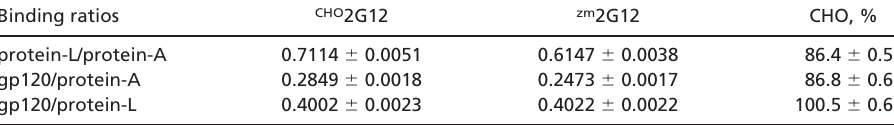
Table 1. Biacore characterization of the antigen-binding properties of the maize and CHO antibodies Binding ratios